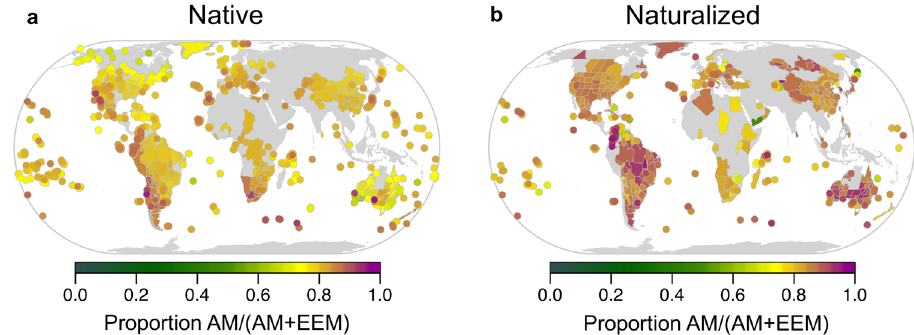
Fig. 1 Locations of regions used in study with associated proportion AM:EEM. Maps of geographical regions showing the proportion of arbuscular mycorrhizal relative to ectomycorrhizal (AM/AM + EEM) plant species for native and naturalized fl oras included in this study ( a mainland n = 515, island n = 313; b mainland n = 287, island n = 100).